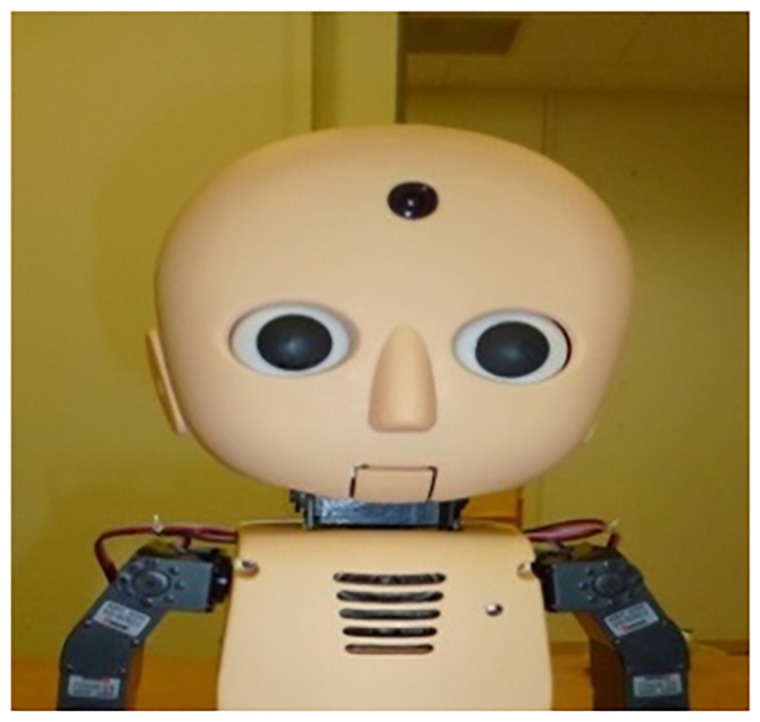
M3-synchy (mechanical robot).